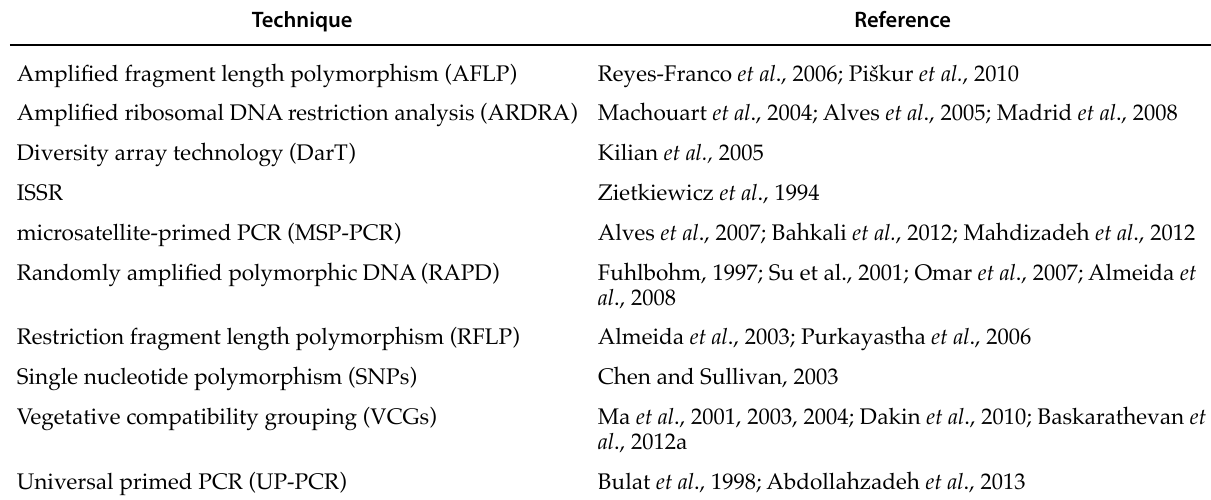
Table 2. Common techniques that have been used in studies of genetic